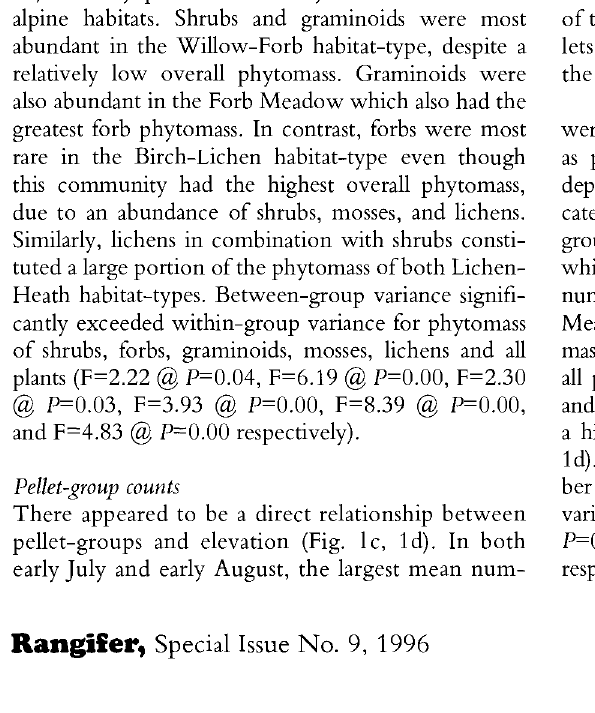
Fig. la, b. Mean phytomass (gnr 2 ) of mosses, lichens, shrubs, forbs, graminoids in nine habitat-types, numbered from lowest to highest elevation. 1 =Riparian Willow, 2=Birch Moss, 3=Birch-Lichen, 4=Willow-Forb, 5=Lichen-Heath, 6=Alpine Lichen-Heath, 7=Forb Meadow, 8=Snowpatch, 9=Lichen- Grass. Gram.=Graminoids. Standard deviation exceeds 70% of the mean value in all cases, except where * is